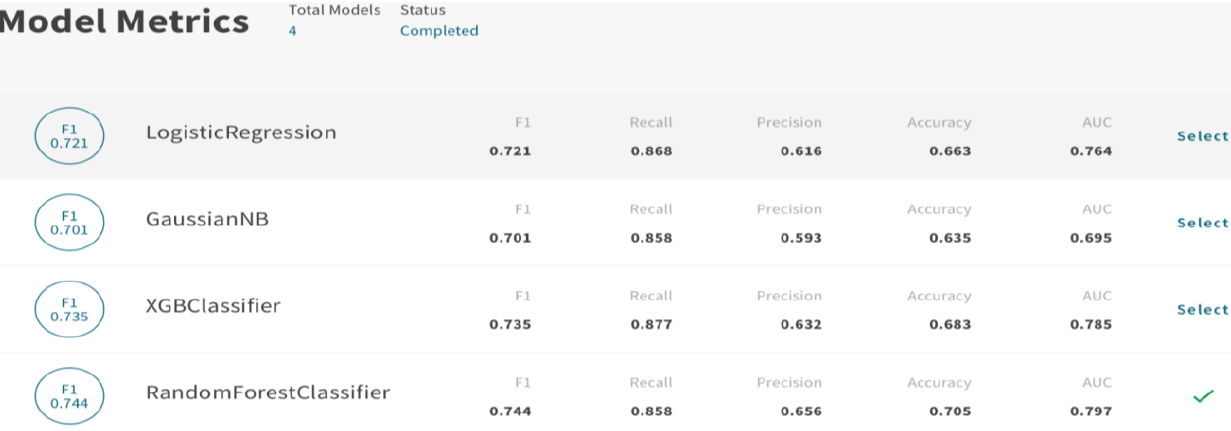
Figure 9. Summary of the generated models’ performance with the AA approach using the Qlik Sense platform.